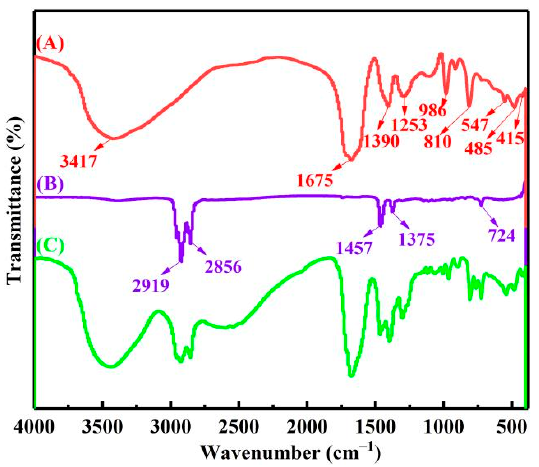
Figure 9. The FTIR of extract ( A ) 30% N235 + 10% 2 − octanol + 60% kerosene organic phase ( B ) loaded organic phase ( C ).